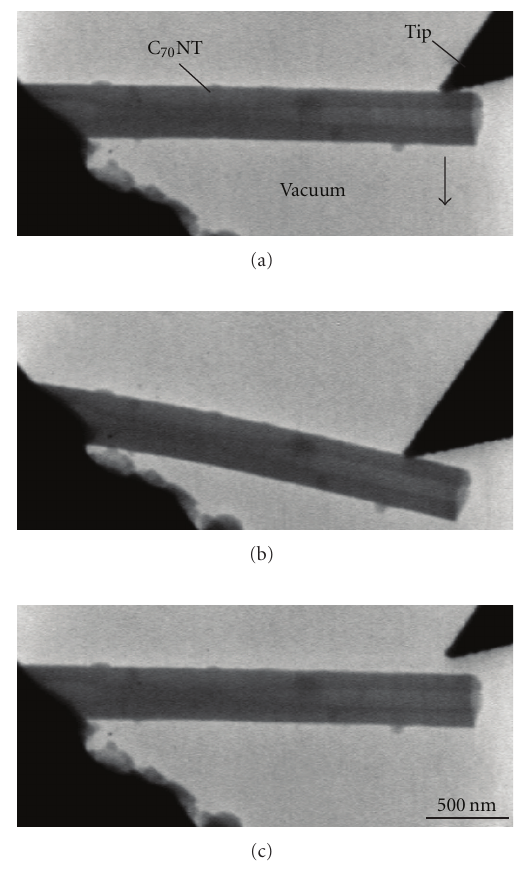
Figure 1: A time-sequence series image and the separation like galley is forbidden. Time-sequence series of bright-field images of cantilever-beam-type loading bending of single-crystal C 70 nano- tube with outer diameter of 270 nm and inner diameter of 100 nm. One end of the nanotube is fixed on a gold plate. The arrow indicat es the direction of loading imparted by the tip of AFM cantilever. This bending test was performed in the vacuum.